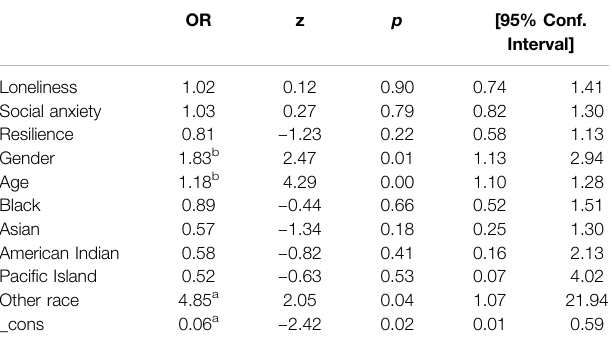
TABLE 1 | Variance In fl ation Factors and Correlations. Loneliness